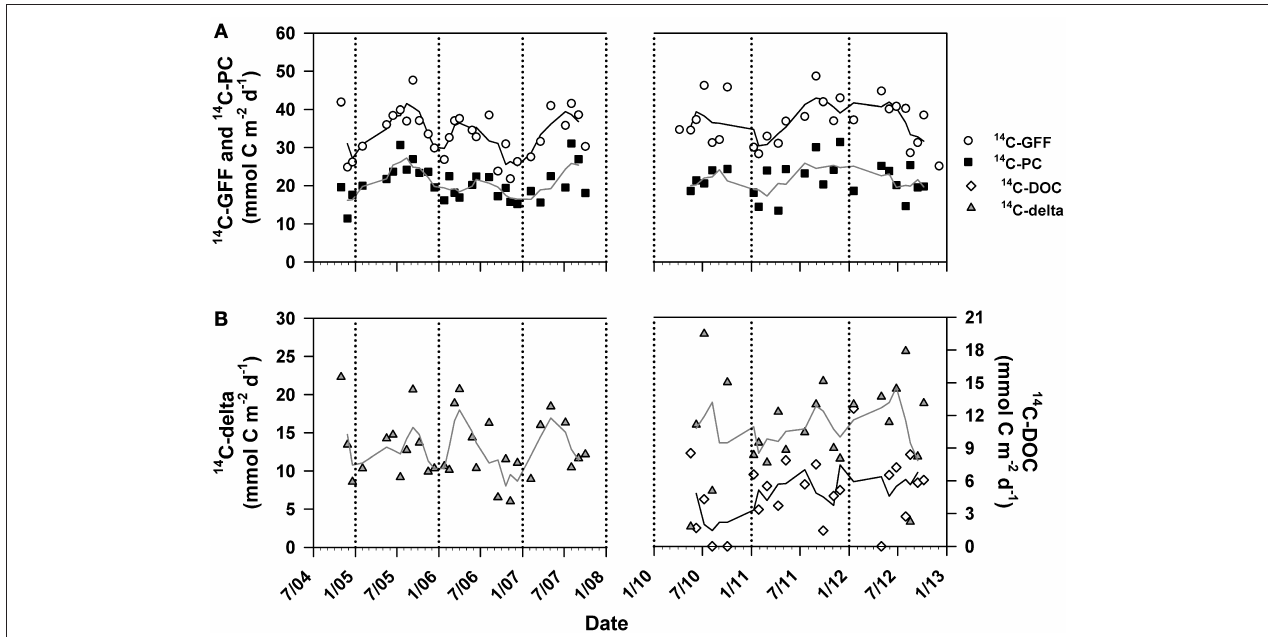
FIGURE 6 | Time-series measurements of depth-integrated (0–75m) rates of (A) 14 C-GFF (open circles) and 14 C-PC production (closed squares). Also depicted are depth-integrated (0–75m) rates of (B) 14 C-delta production ( 14 C-GFF— 14 C-PC; gray triangles) and 14 C-DOC production (open diamonds). Lines are 3-point running means. Break in time-series indicate period where measurements were not conducted. Rates of 14 C-DOC below detection were considered to be equal to zero.